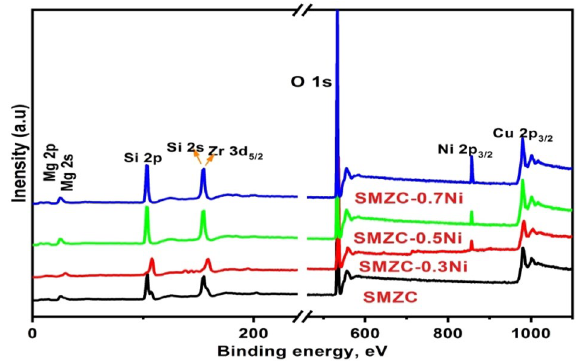
Figure 1. XPS survey of SMZC nanoceramics doped with (0.0–0.7) Ni 2+ , calcined at 800 °C.